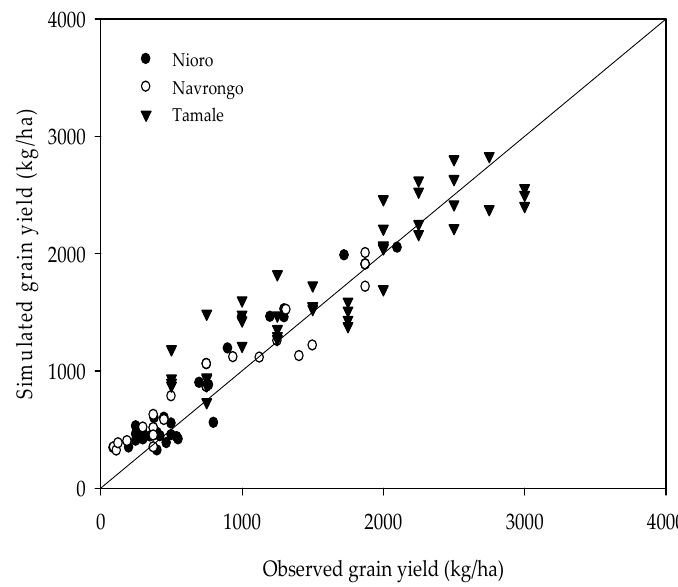
Figure 2. Performance of DSSAT in simulating maize grain yields collected from farmer surveys in 2007 at Nioro, 2012 at Navrongo and 2014 at Tamale site. 2007 at Nioro, 2012 at Navrongo and 2014 at Tamale